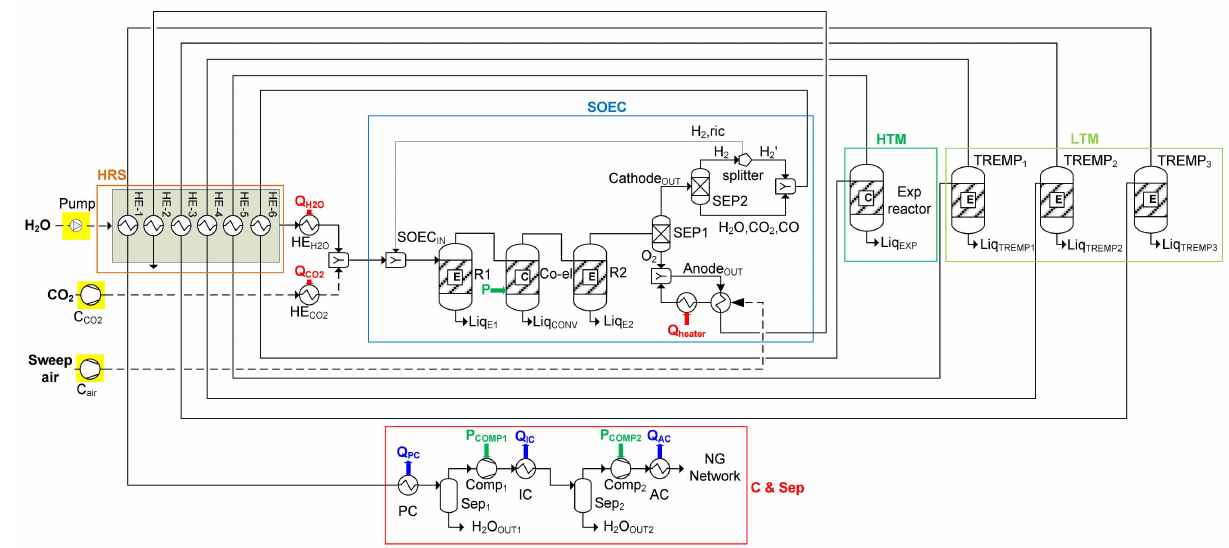
Figure 3. Schematic of the P2G system implemented into the thermodynamic